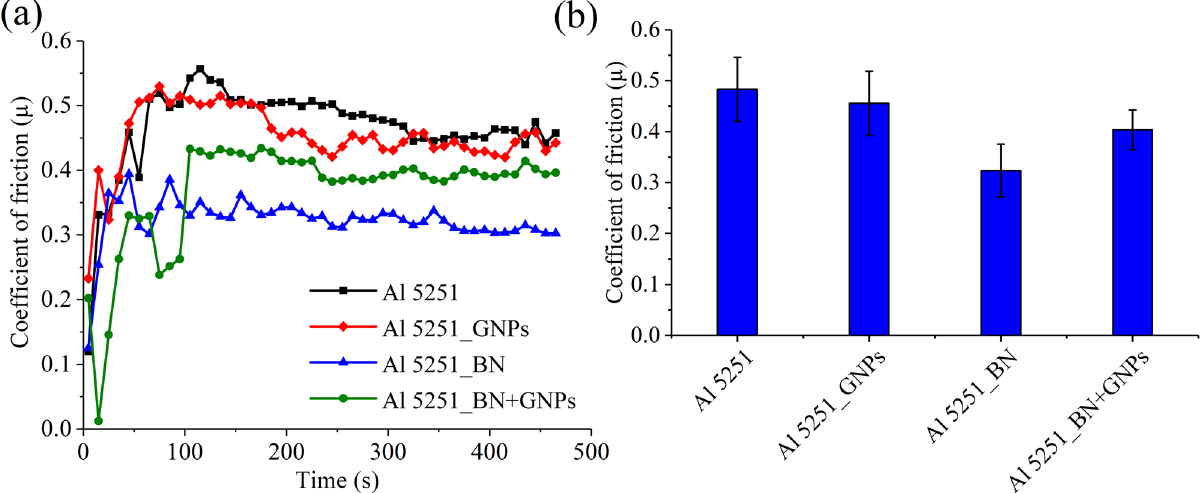
Figure 10: Behaviour of the COF with the time of the fabricated